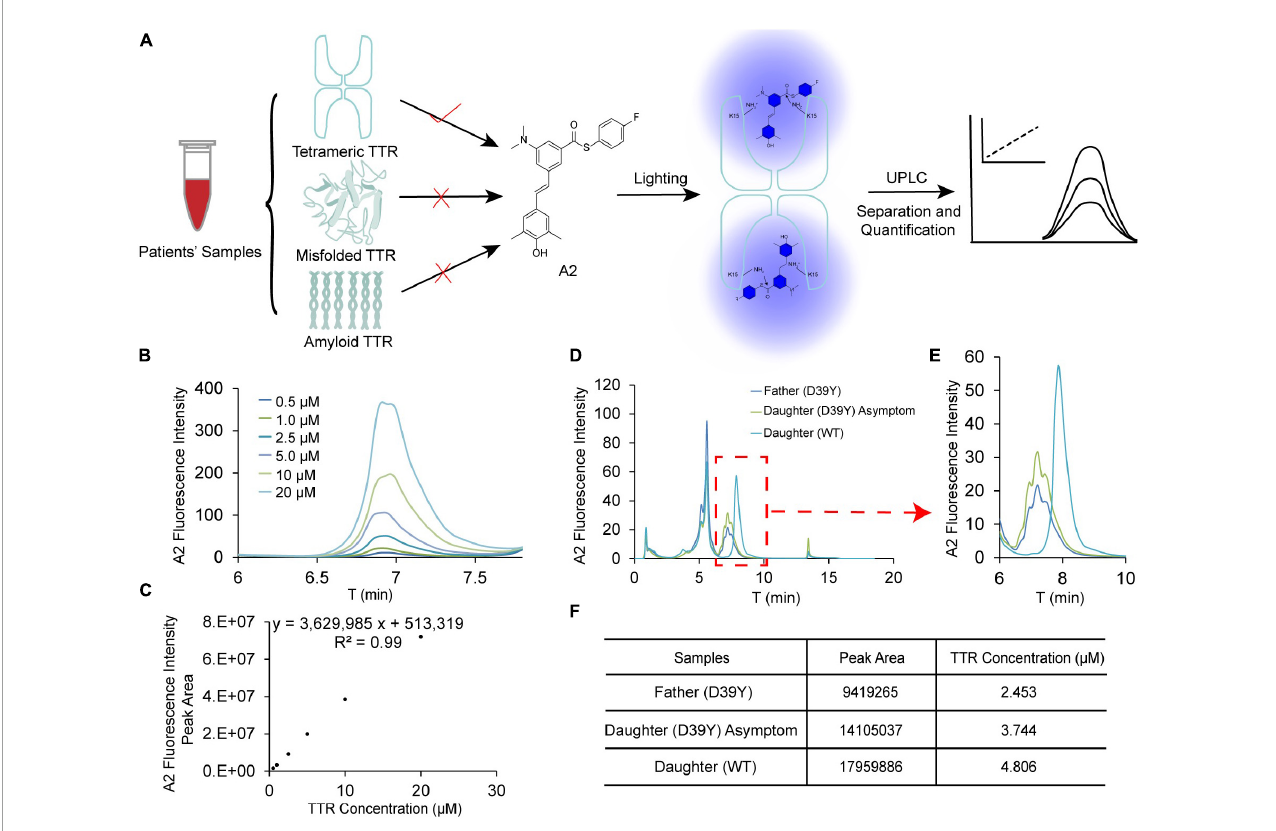
FIGURE6 Quantification of tetramer TTR concentration in patient’s blood serum. (A) The scheme for quantification of TTR tetramer concentration in patient’s serum using by UPLC. A2 selectively reacts with TTR tetramer and reports on the concentration by its fluorescence. (B,C) Linear correlation between TTR concentration and fluorescence intensity of A2. (D) The raw chromatographic data for the symptomatic father (D39Y), asymptomatic daughter (D39Y) and healthy daughter (WT) on UPLC detected by A2 fluorescence. (E,F) Quantification of the peak area and TTR tetramer concentration of three samples.